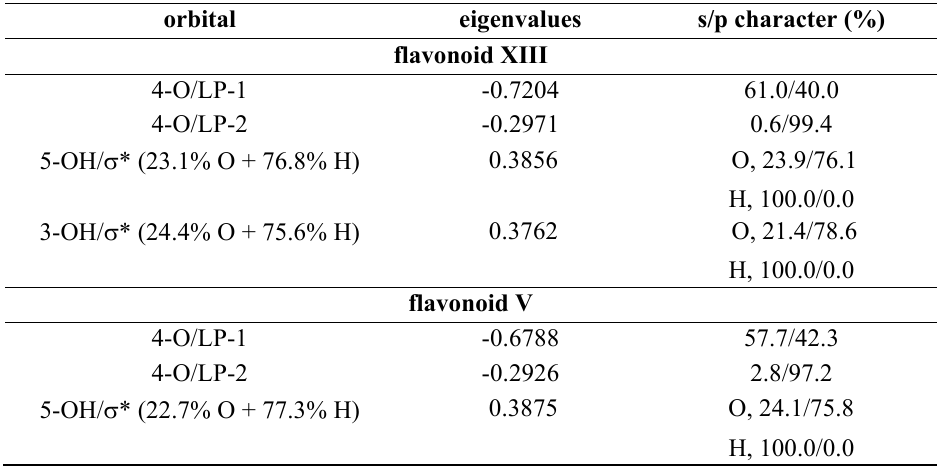
Table 7. Characteristics of orbitals involved in hydrogen bonding HB_1 and HB_2 for flavonoids V (luteolin) and XIII (quercetin) computed in gas phase at the B3LYP/6- 311++G** theoretical level. LP = oxygen lonely pair. Atom numbering as in Figure